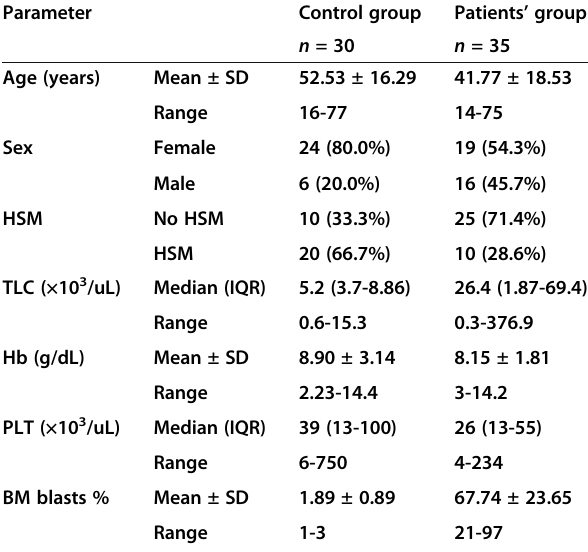
Table 1 Demographic, clinical, and hematological data of AML patients and control groups